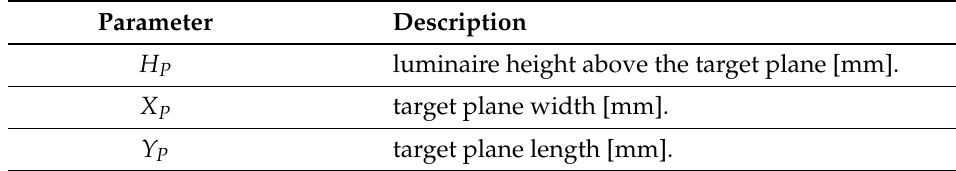
Table 2. Simulation parameters.